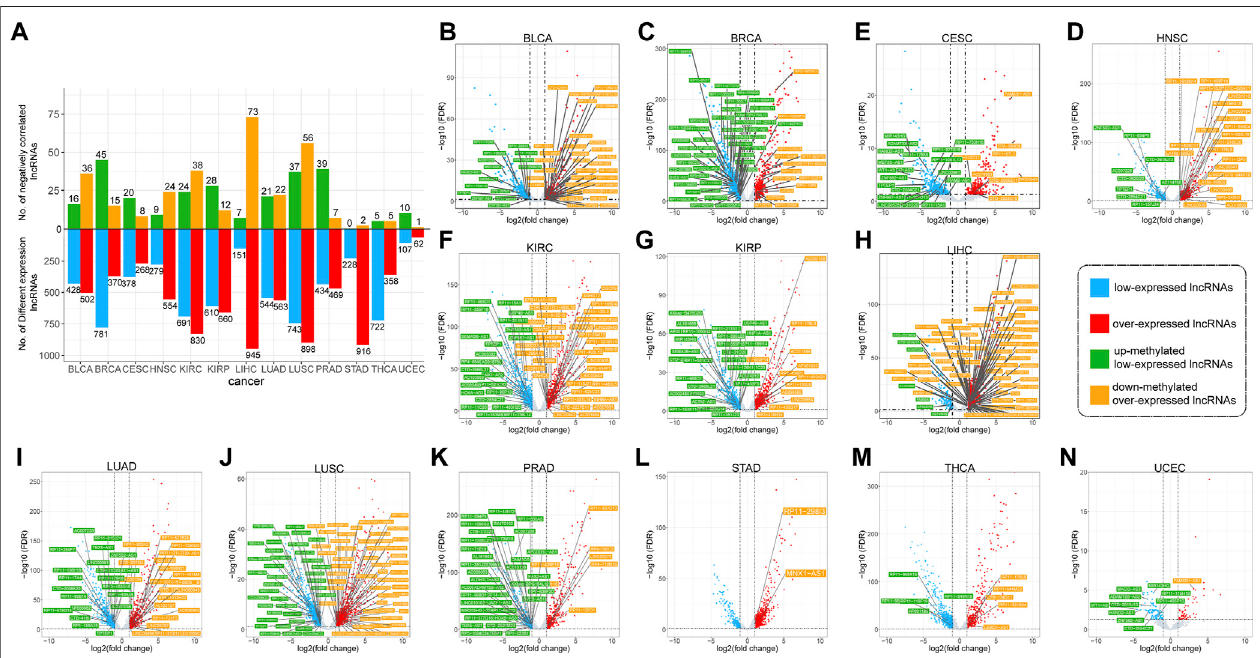
FIGURE 5 | The negatively correlated lncRNAs for cancers (A) Quantitative analysis of lncRNAs that are differently expressed and negatively correlated (B – N) Distribution and names of negatively correlated lncRNAs for cancers. Red and blue dots represent differentially expressed lncRNAs. In which, blue represents down- expressed lncRNAs,and redrepresentsup-expressedlncRNAs.Greenandyellowboxesrepresent thenamesofnegatively correlatedlncRNAs.Wheregreenindicates lncRNAs with up-methylated and low-expressed, and yellow represents lncRNAs with down-methylated and over-expressed.